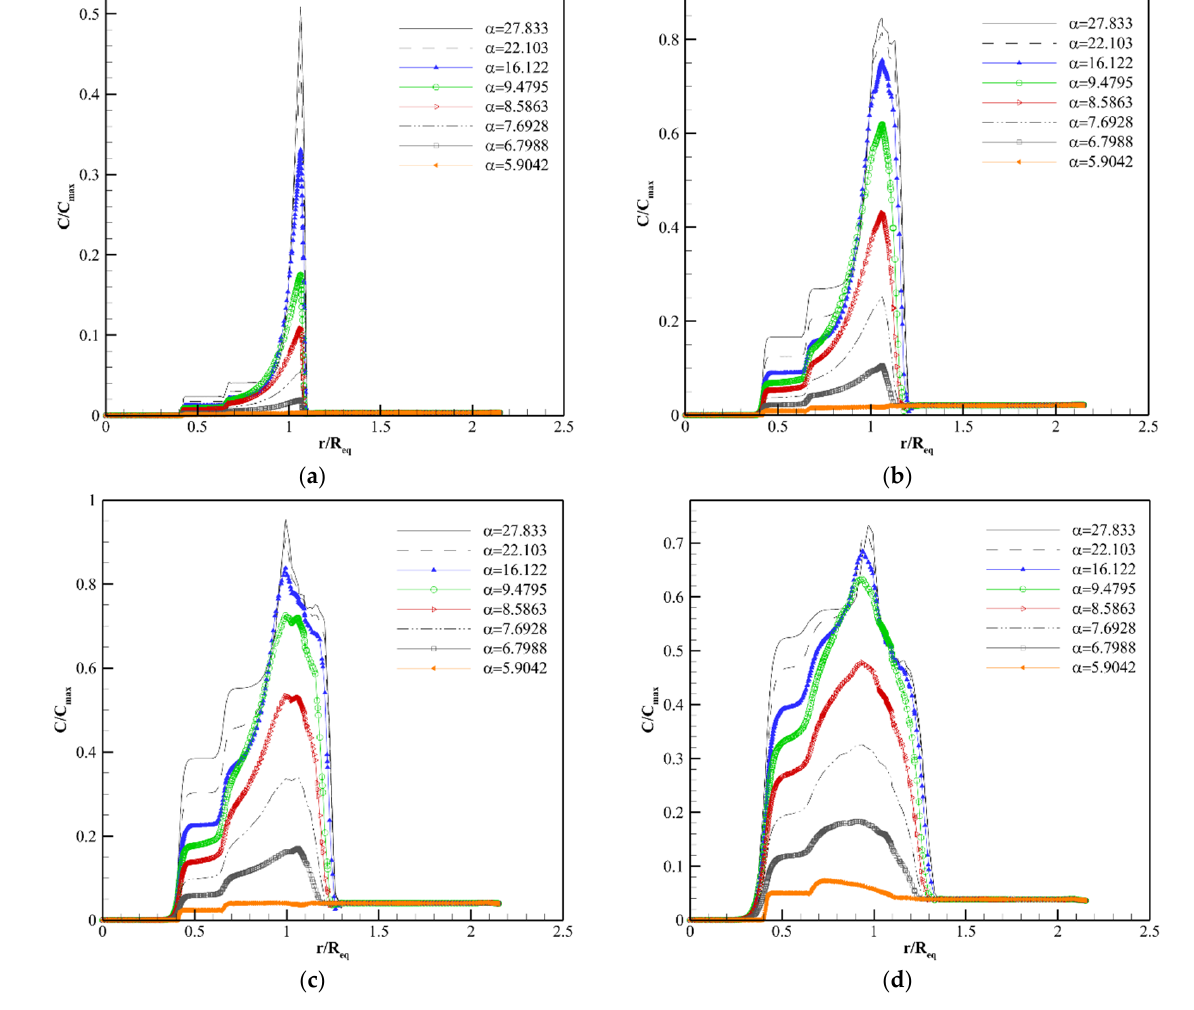
Figure 11. Distribution of IgG concentration along line 1. ( a ) 1 h post-injection. ( b ) 8 h post-injection. ( c ) 24 h post-injection. ( d ) 72 h post-injection.